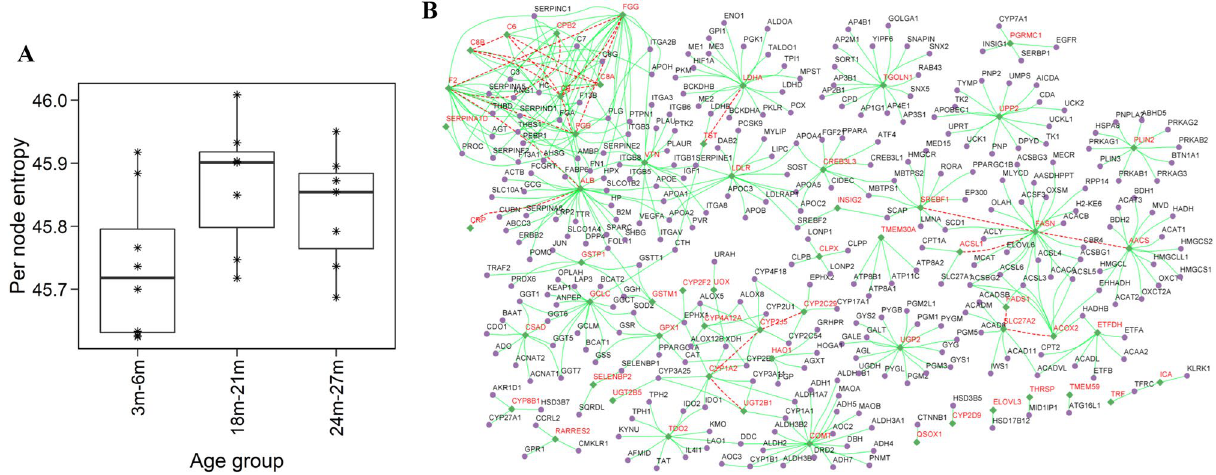
Figure 3. Network entropy-based analysis of liver ageing network. ( A ) Boxplot showing the change in network entropy across different age groups. Sample-wise entropy is calculated and is normalized by number of nodes in its corresponding network. ( B ) Network of top 50 nodes with significant change in local entropy and their neighbours. Top nodes are colored in red and the edges connecting them are shown with red dashed lines. Edges between neighbours are not